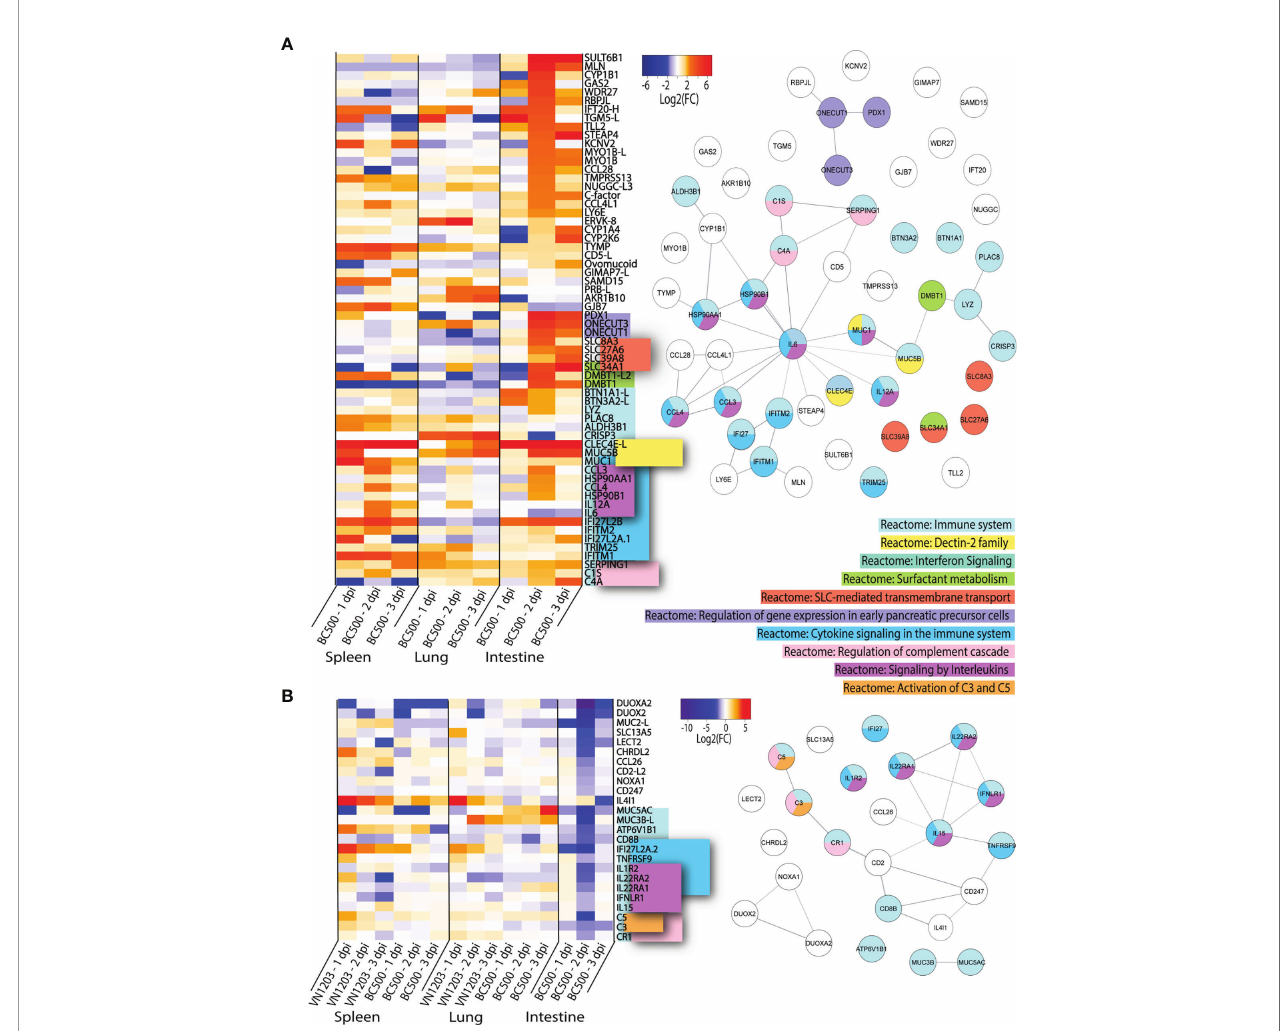
FIGURE 6 | Genes up or downregulated following BC500 infection of ducks. Lists of statistically signi fi cant (FDR<0.05) genes were compared for similarity in expression (Log2(FC)>1.5) and clustered together if they were uniquely upregulated in at least 2 out of 3 tissues in BC500 infected ducks (A) . Lists of statistically signi fi cant (FDR<0.05) downregulated (Log2(FC)<-1) in intestine of BC500 ducks were compared to other tissues of both VN1203 and BC500 infected ducks to determine uniquely downregulated genes in intestine (B) . STRING diagrams depict predicted protein-protein interactions between the products of each gene, while colour coding is based on term enrichment of Reactome pathways. No colour means that the genes did not enrich any of the Reactome terms. Reactome terms were considered signi fi cant if FDR<0.05. Enrichment and STRING diagram was created using the STRINGTIE app in